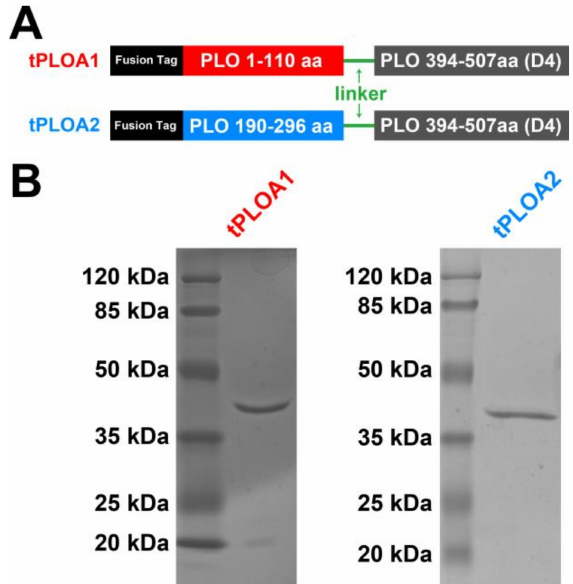
Figure 1. Design and preparation of tPLOA1 and tPLOA2. ( A ) The structure scheme of tPLOA1 and tPLOA2. tPLOA1 contains a segment aa 1–110 (marked red) and a D4 structure (marked gray) of the pyolysin (PLO) molecule. tPLOA2 contains a segment aa 190–296 (marked blue) and a D4 structure (marked gray) of the PLO molecule. Both of the two recombinant proteins contain a polypeptides fusion tag (marked black), which is encoded by pET-32a ( + ) plasmid, at their amino terminus and a polypeptides linker (marked green) between the amino terminus part and the D4 structure of the recombinant proteins; ( B ) SDS-PAGE results showed the purified tPLOA1 and tPLOA2. The two recombinant proteins showed similar molecular